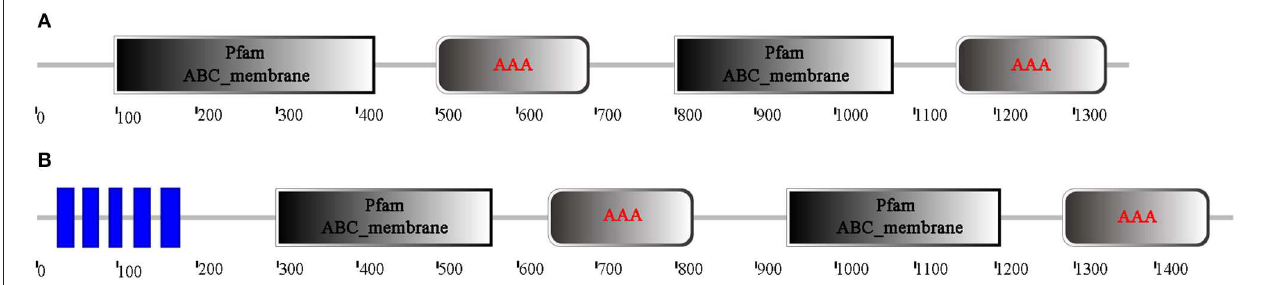
FIGURE 1 | Domain architecture analysis of the deduced amino acid sequences of Mco ABCB1 (A) and Mco ABCC (B) . Mco ABCB1 and Mco ABCC are comprised of two subunits, each with a transmembrane-spanning domain (MSD/ABC_membrane), and a nucleotide-binding domain (NBD/AAA). In addition, Mco ABCC possesses five transmembrane regions in the N-terminate. (For interpretation of the references to color in this figure legend, the reader is referred to the web version of this article).